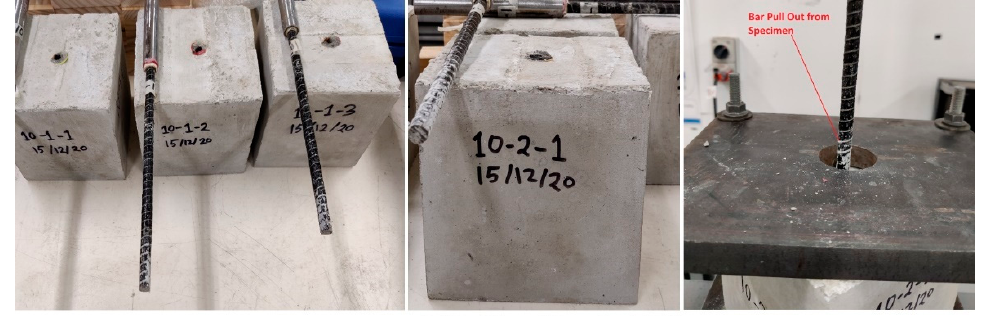
Figure 11 . Pull-out failure of 6-mm BFRP bar specimens.